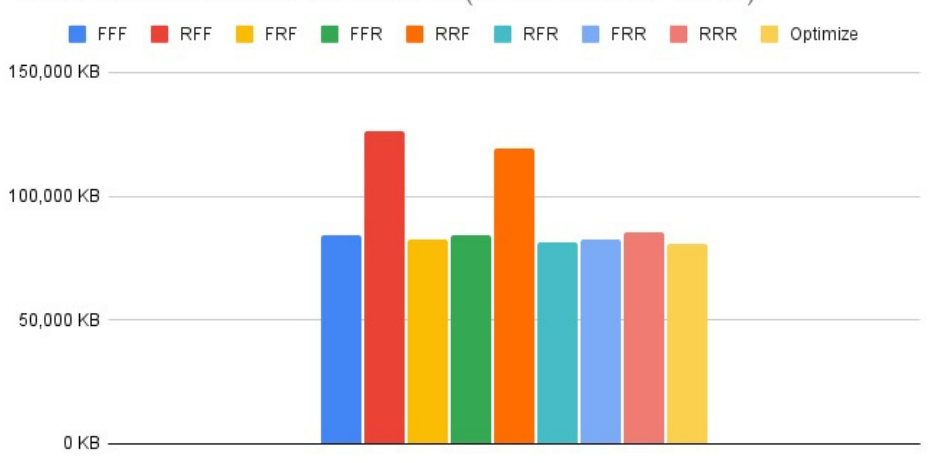
Figure 17. Total DRAM access—DenseNet121 (256 PE/256 KB Buffer).